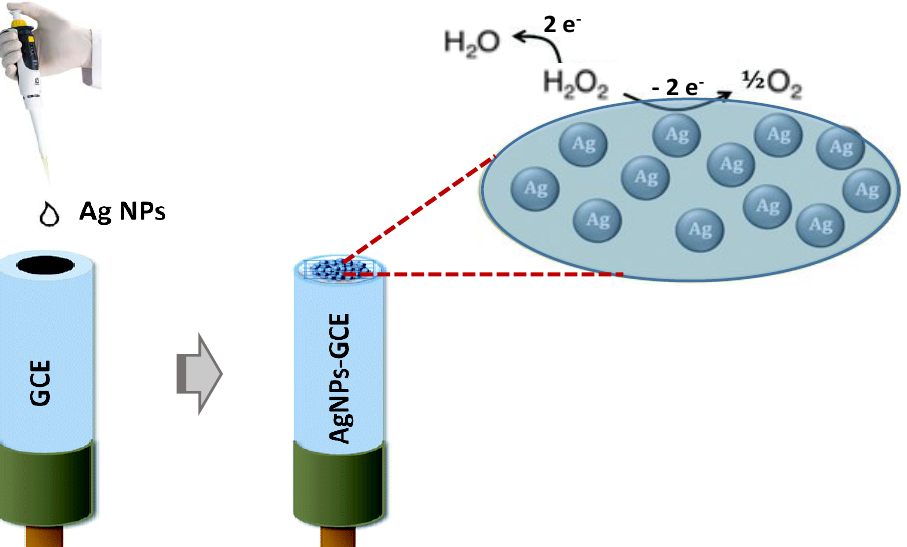
Figure 4. Schematization of the fabrication of modified AgNPs/glassy carbon electrode (GCE). The electrochemical reactions which can occur in the presence of H 2 O 2 are highlighted.